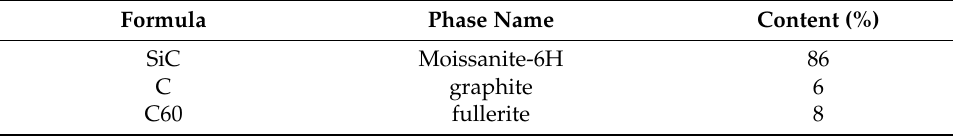
Table 1. Phase composition of SiC